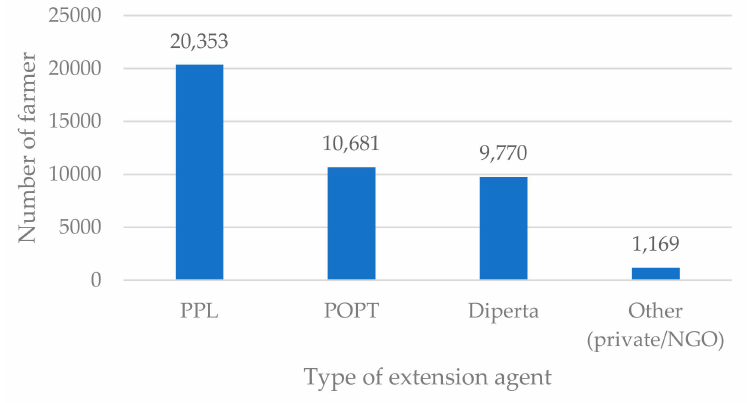
Figure 5. The number of farmers who receive extension services based on the type of extension